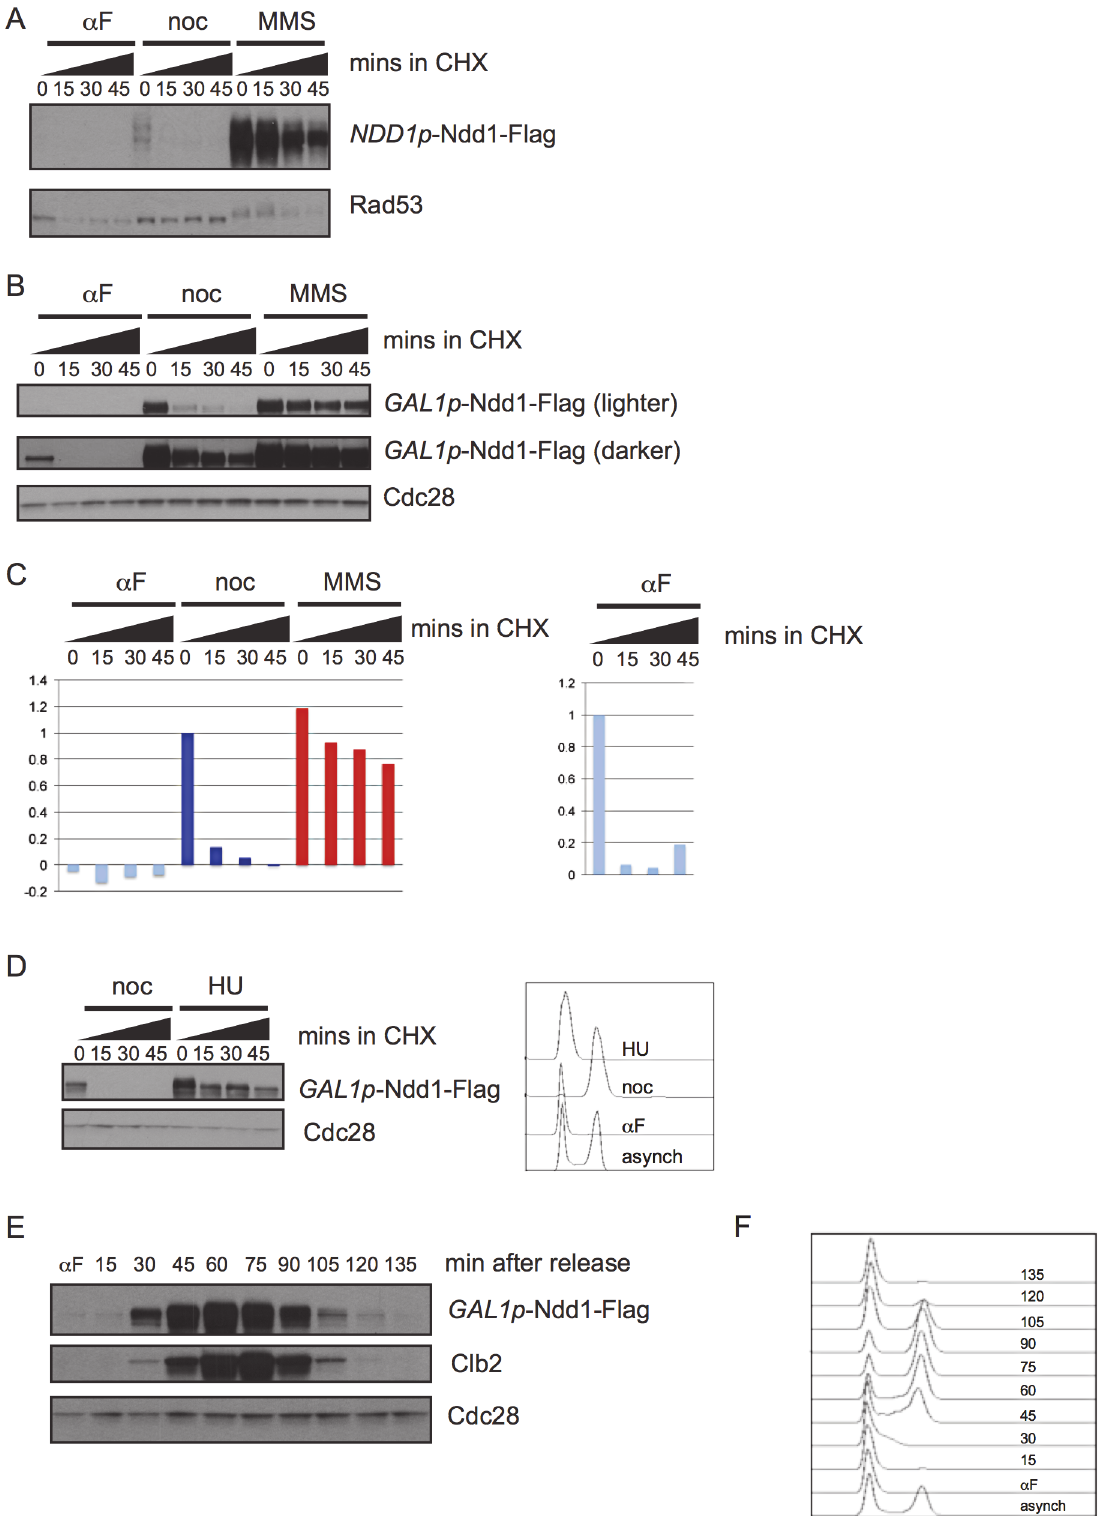
Fig 1. Regulation of Ndd1 turnover. A) Cells expressing Ndd1-Flag from its endogenous promoter were arrested in G1 (with 10 μ g/ml α – g/mlh ( α F)), metaphase (with 10 μ g/ml nocodazole (noc)), or exposed to DNA damage (with 0.05% MMS) for 2.5 hours. Cycloheximide (CHX) was added at 50 μ g/ml